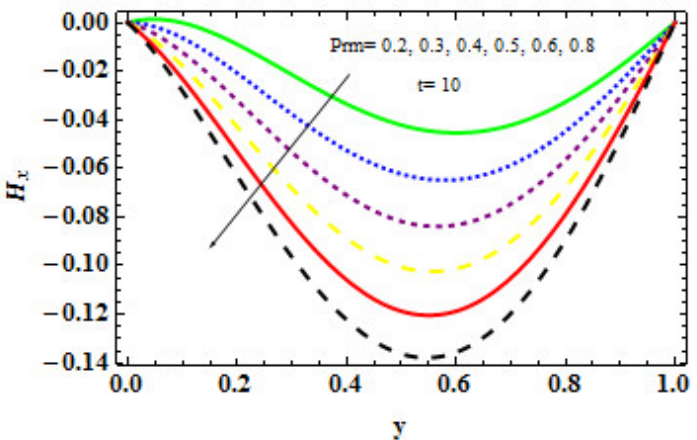
Figure 15. Prm effect on the IMF with respect to time.